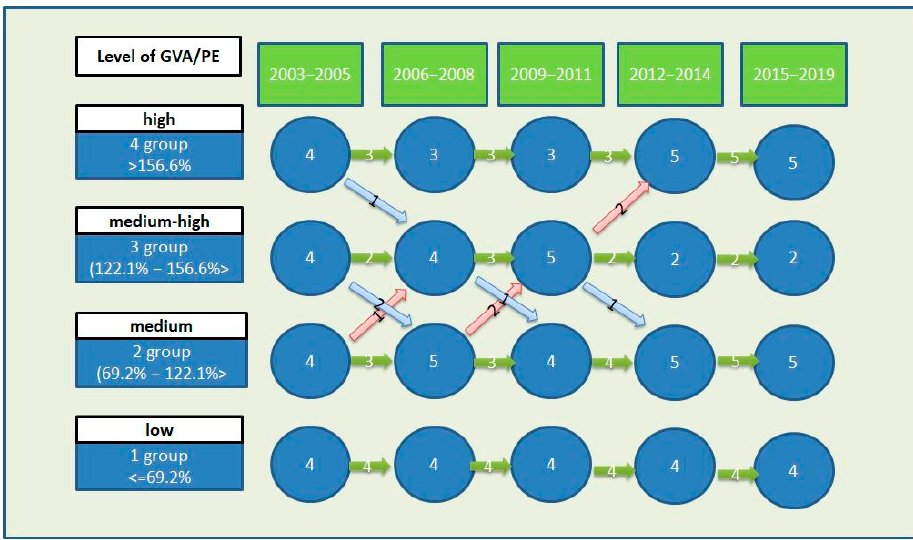
Figure 6. The flow of regions according to the relative distribution of the gross value added per person employed in section A (agriculture, forestry, hunting, and fishing) for voivodeships in four sub-periods in 2003–2014 (Own study, based on the Local Data Bank).